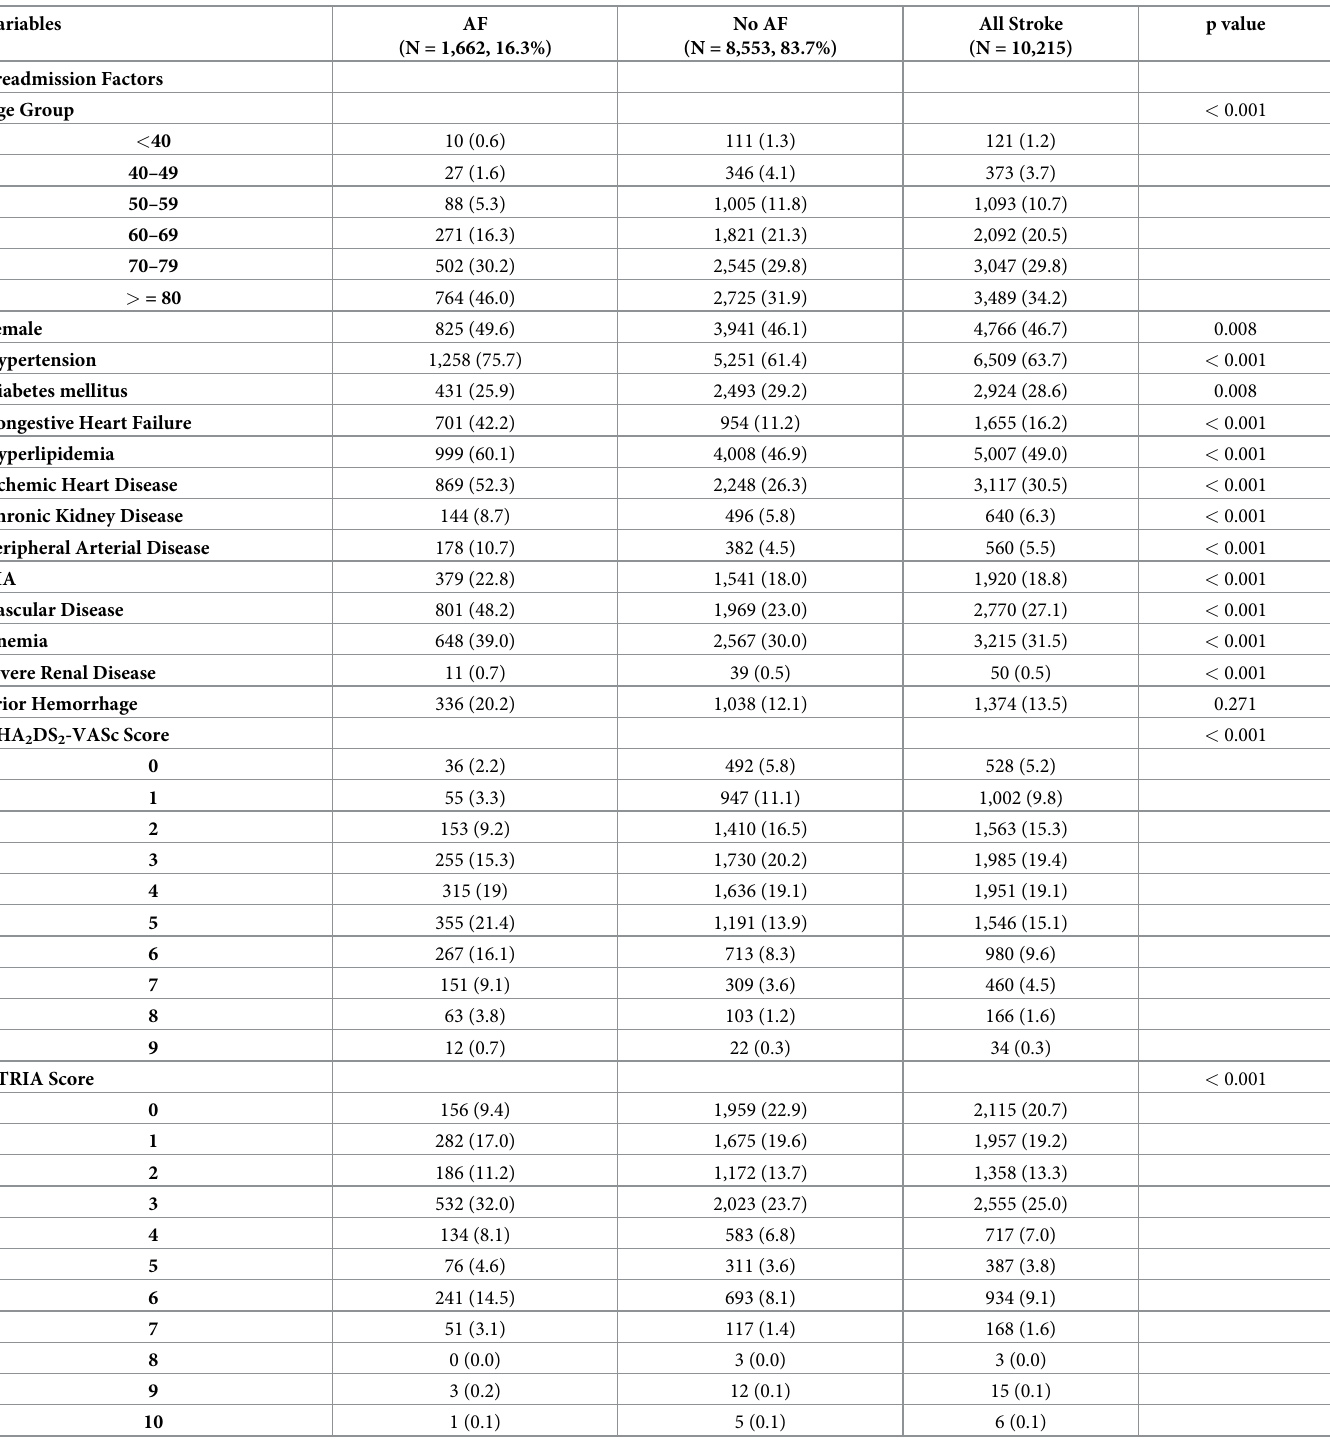
Table 1. Baseline characteristics of study